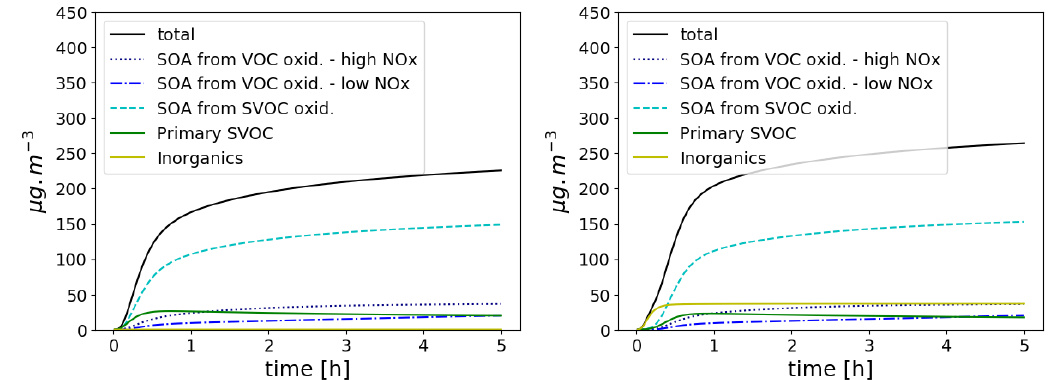
Figure 9. Time evolution of organic and inorganic concentrations for the exhaust test case: without NH 3 emissions ( left ) and with NH 3 emissions ( right ).